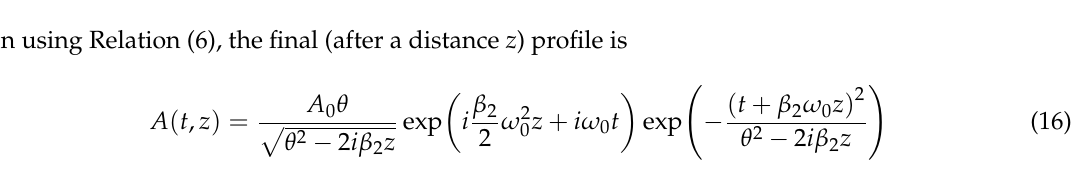
Figure 2. A false-color presentation of the pulse’s intensity | A ( t , z ) | 2 (Equation (14)) as a function of the normalized time τ ≡ t / θ and the normalized distance ζ ≡ β 2 z / θ 2 .